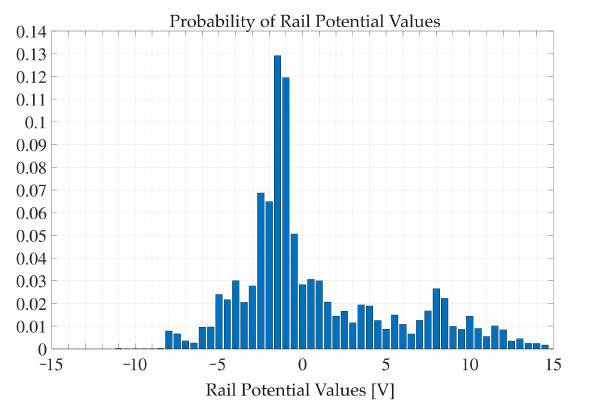
Figure 9. The normalized histogram of the rail potential